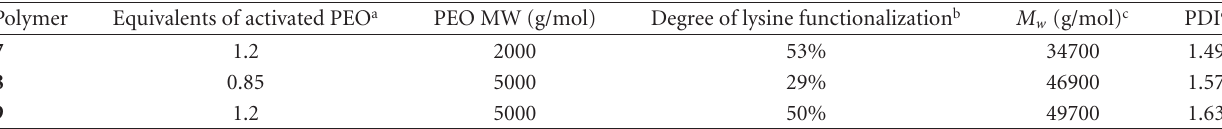
Table 1: Characterization data for PEA-PEO graft copolymers 7–9 .